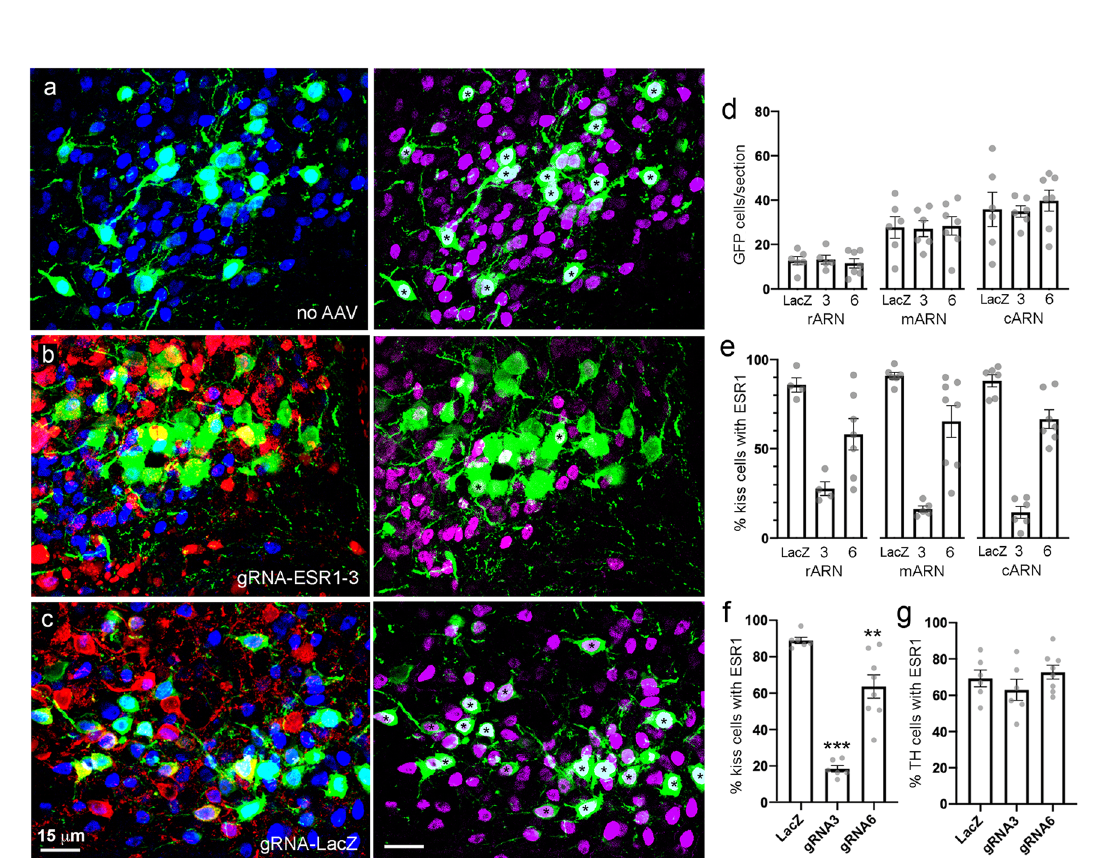
Fig. 5 | CRISPR-Cas9 knockdown of ESR1 expression in adult ARN KISS neurons.